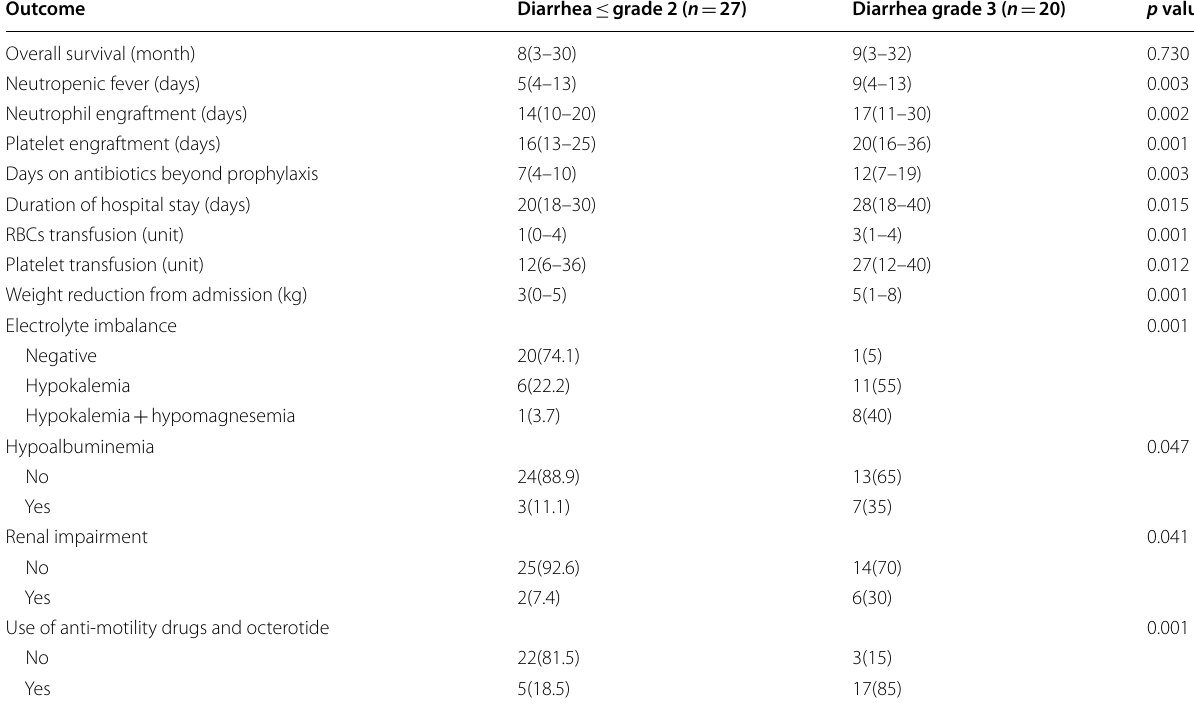
Values are expressed as median (range) and n